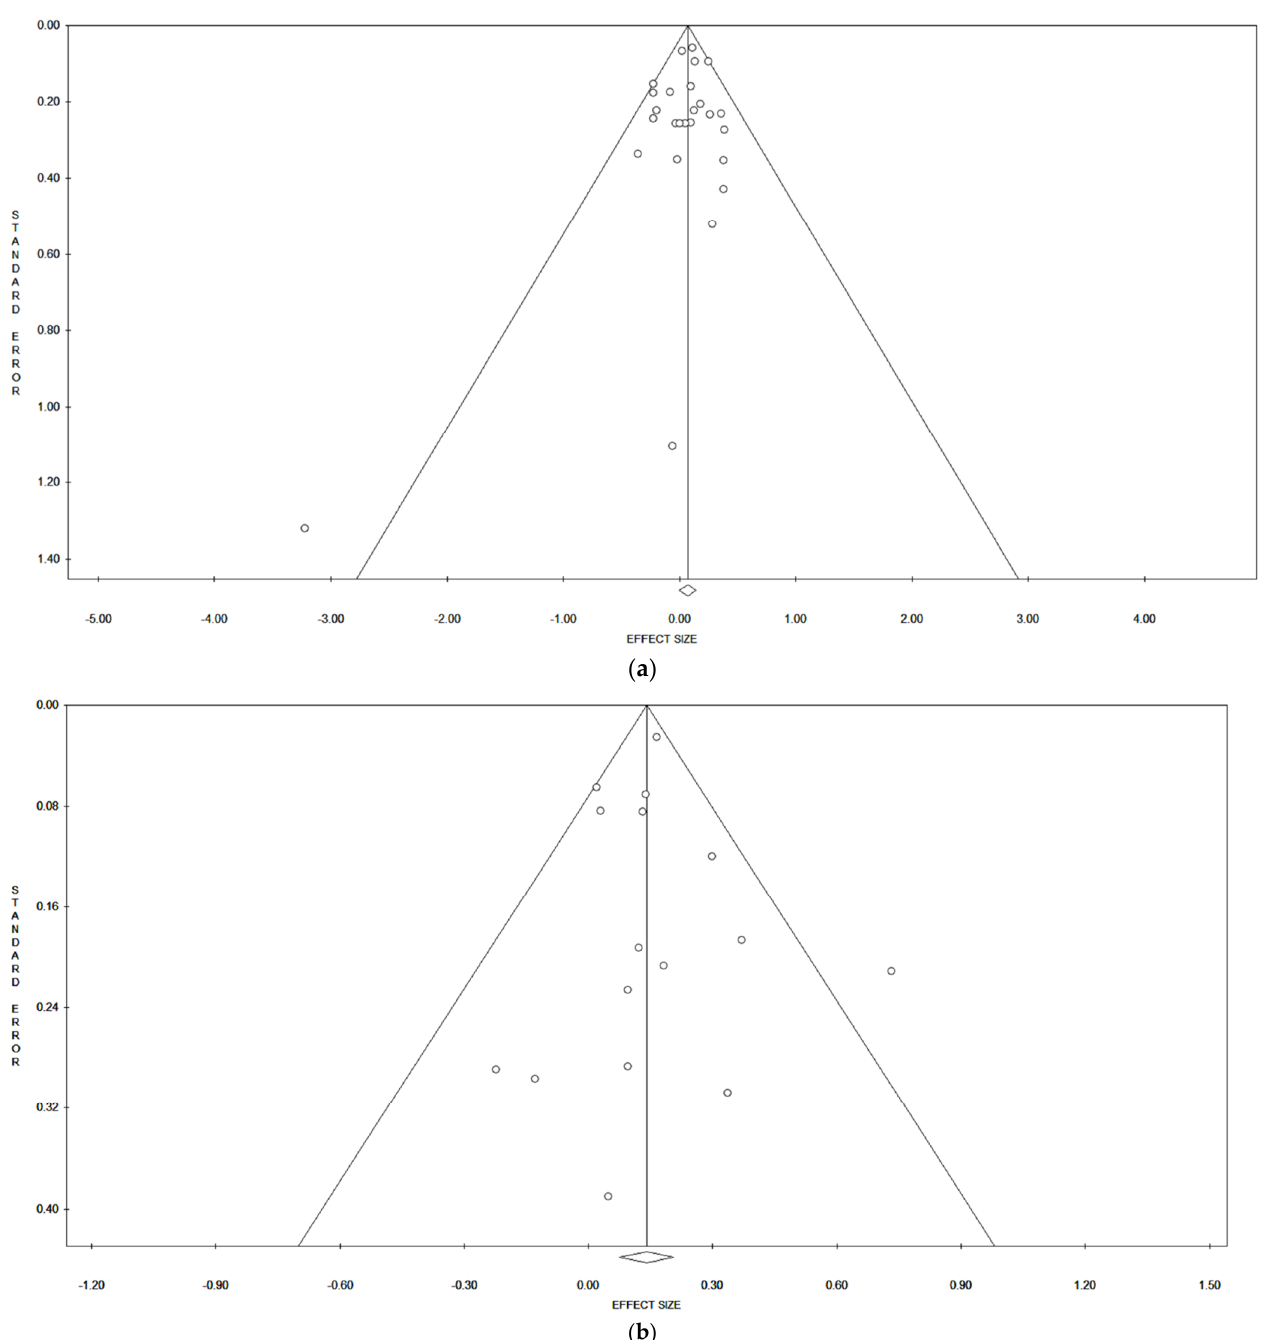
Figure A1. Funnel Plot of publication bias of OC ( a ) and MHT ( b ) use and risk of CMM.